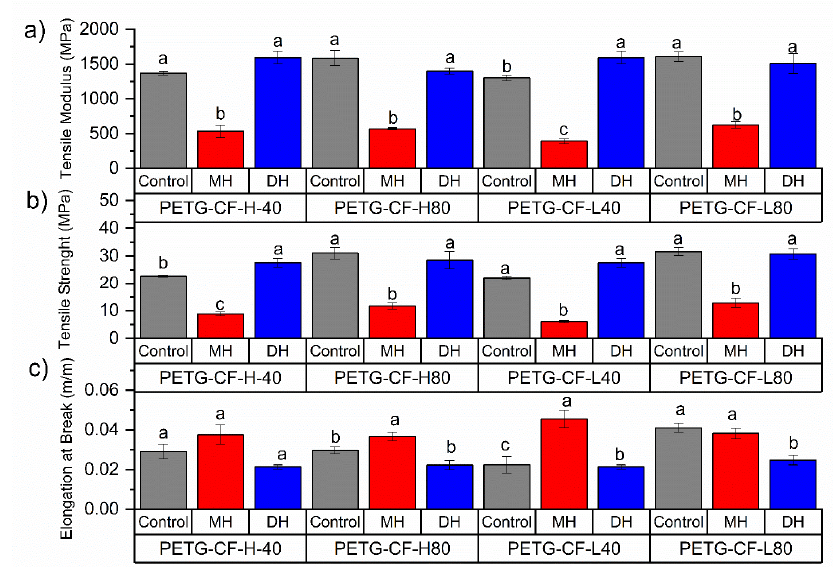
Figure 4. Change in the tensile modulus ( a ), tensile strength ( b ) and elongation at break ( c ) of FDM dumbbells due to the DH or MH sterilization process as measured in the PETG. Grey bar: control sample; blue bar: dry heat sterilization; and red bar: moist heat sterilization. a–c Different letters show statistically significant differences between formulations ( p < 0.05).